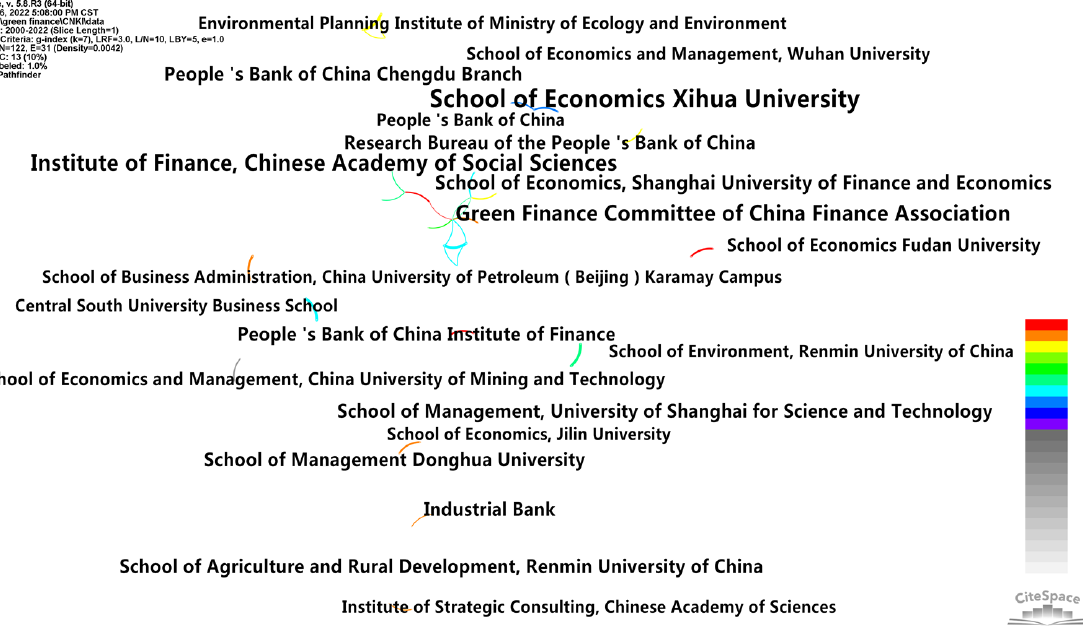
Figure 5. Cooperation network of the domestic institutions.